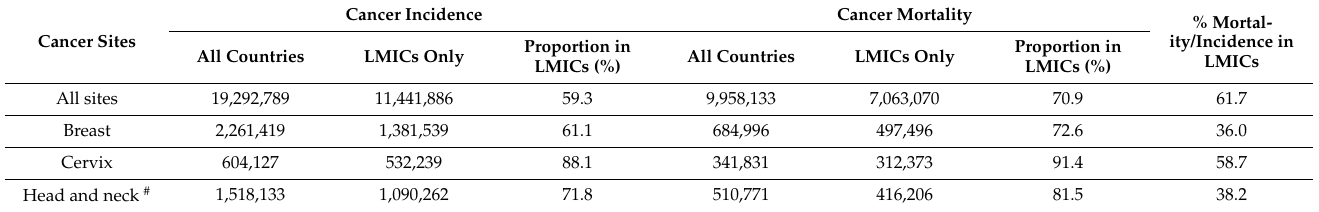
Table 1. Estimated number of cancer cases and deaths as per the Global Cancer Observatory in ages (0–85+ years) pertaining to breast, cervix and head and neck region globally and in low-middle- income countries (LMICs) in 2020 [1]. Countries classified in various income groups based on the World Bank